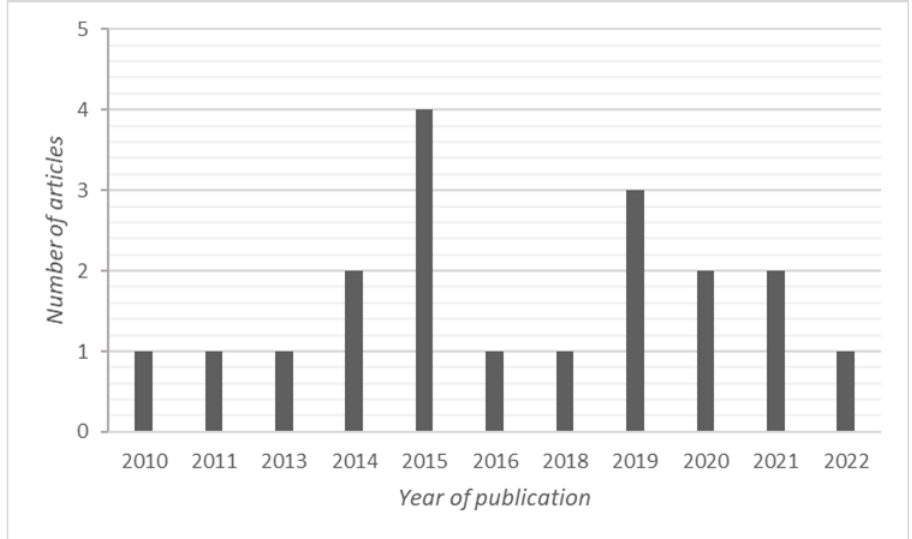
Figure 2. Distribution of the articles by year of publication.